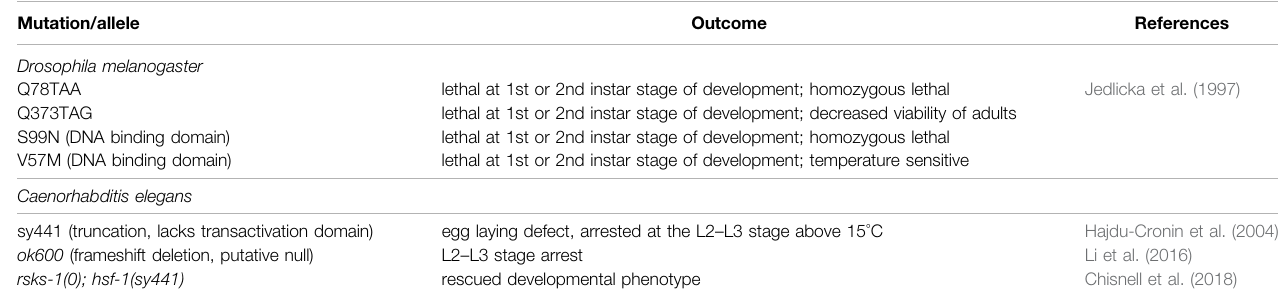
TABLE 2 | HSF1 loss and organismal